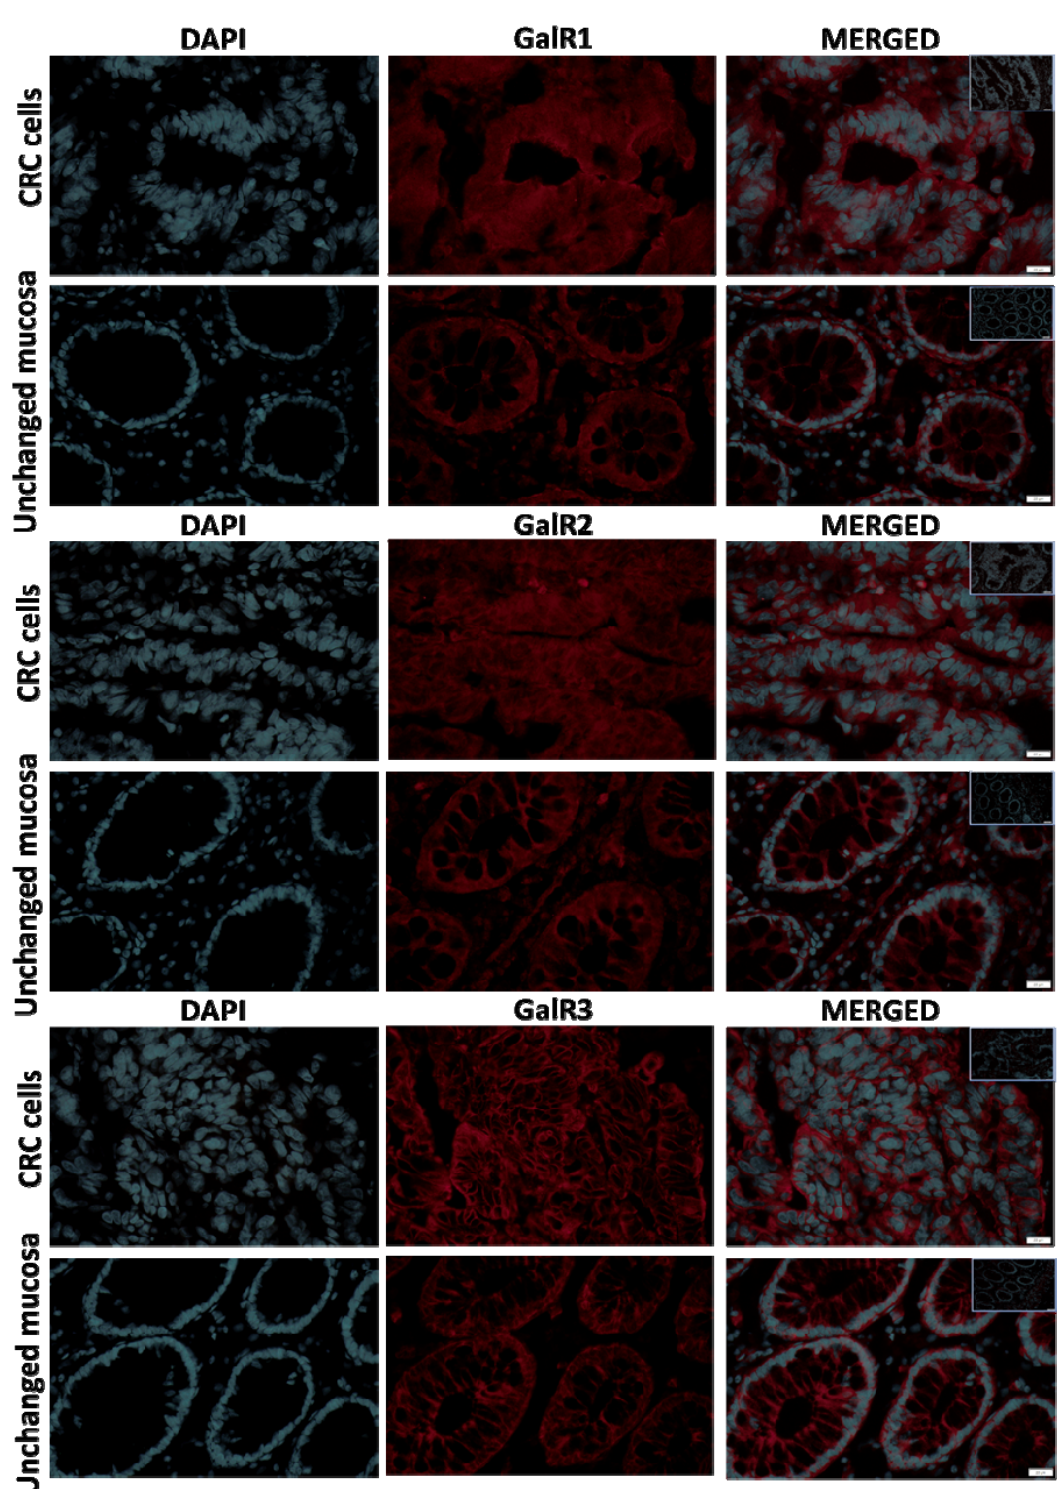
Figure 3. The immunolocalization of GalR1, GalR2 and GalR3 proteins was confined to the cell membrane and cytoplasm of colorectal cancer cells and epithelial cells (enterocytes and goblet cells) of the unchanged mucosa of the large intestine (Figure 3). In addition, the immunoreactivity of GalR1-3 proteins was observed in the cell membrane and cytoplasm of intestinal immune/stromal cells, the myenteric plexuses and smooth muscle cells (unpublished). Negative control was added as inserts in each merged